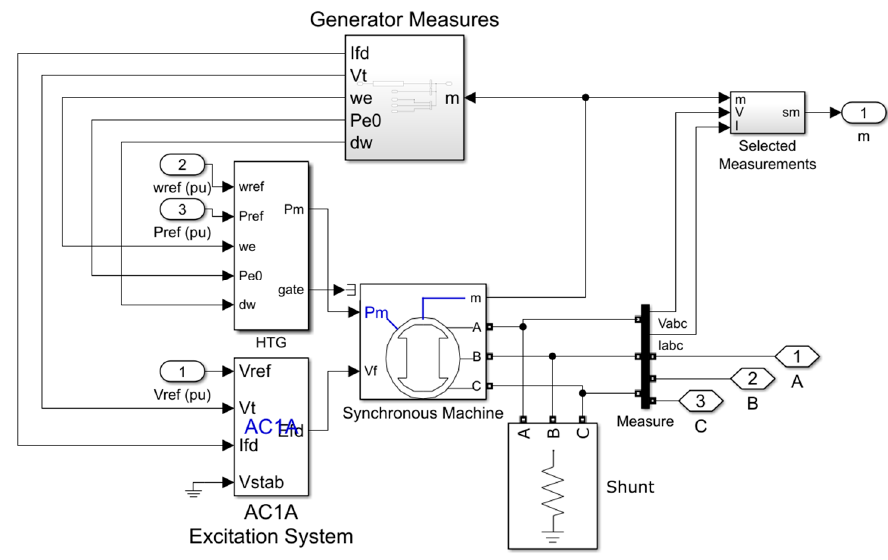
Figure 12. Schematic model of hydropower plant.